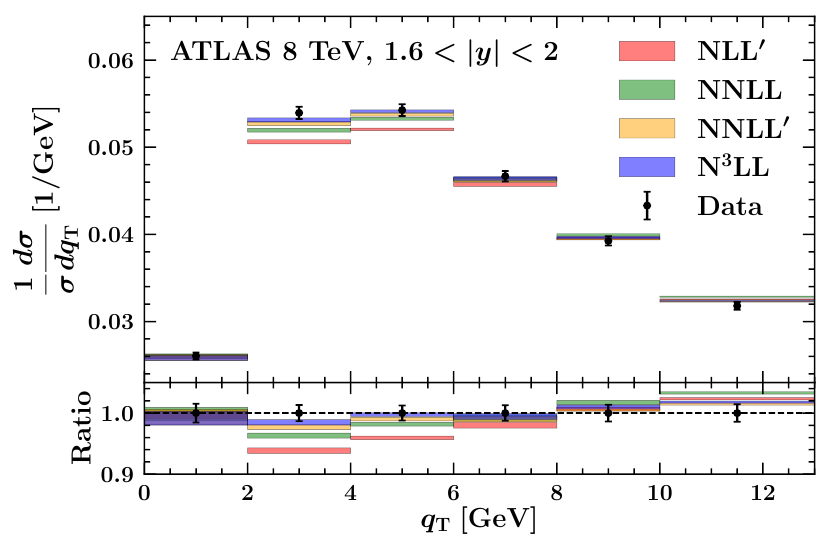
Figure 7 . Comparison between experimental data for the ATLAS 8 TeV measurements in the bin 66 GeV < Q < 116 GeV and 1 : 6 < j y j < 2 and the theoretical predictions obtained from the (cid:12)ts to all perturbative orders considered in this analysis, i.e. NLL 0 , NNLL, NNLL 0 , and N 3 LL (see section 2.4). The layout of the plot is the same as in (cid:12)gure